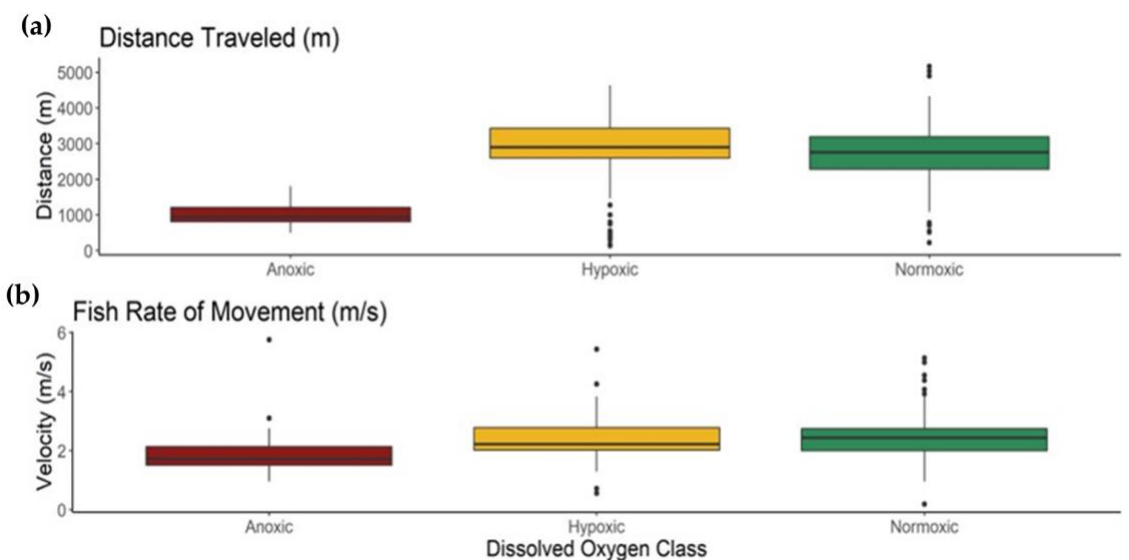
Figure 6. Fish distance traveled ( a ) and rate of movement ( b ) was lower during periods of anoxia; ( a ) Boxplots represent range and median values and quartiles (5th, 25th, 75th, and 95th) for daily distance traveled (m) per dissolved oxygen concentration class. Dots represent outliers. ( b ) Boxplots represent range and median values and quartiles (5th, 25th, 75th, and 95th) for rate of movement (m/s) per dissolved oxygen concentration class.